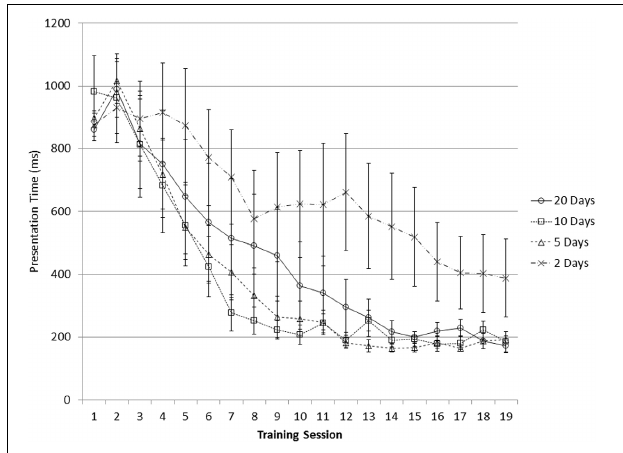
Table 2 | Regression slopes reflecting averaged session-wise stimulus presentation time decrease (in milliseconds; standard errors of the slopes provided in the parenthesis).